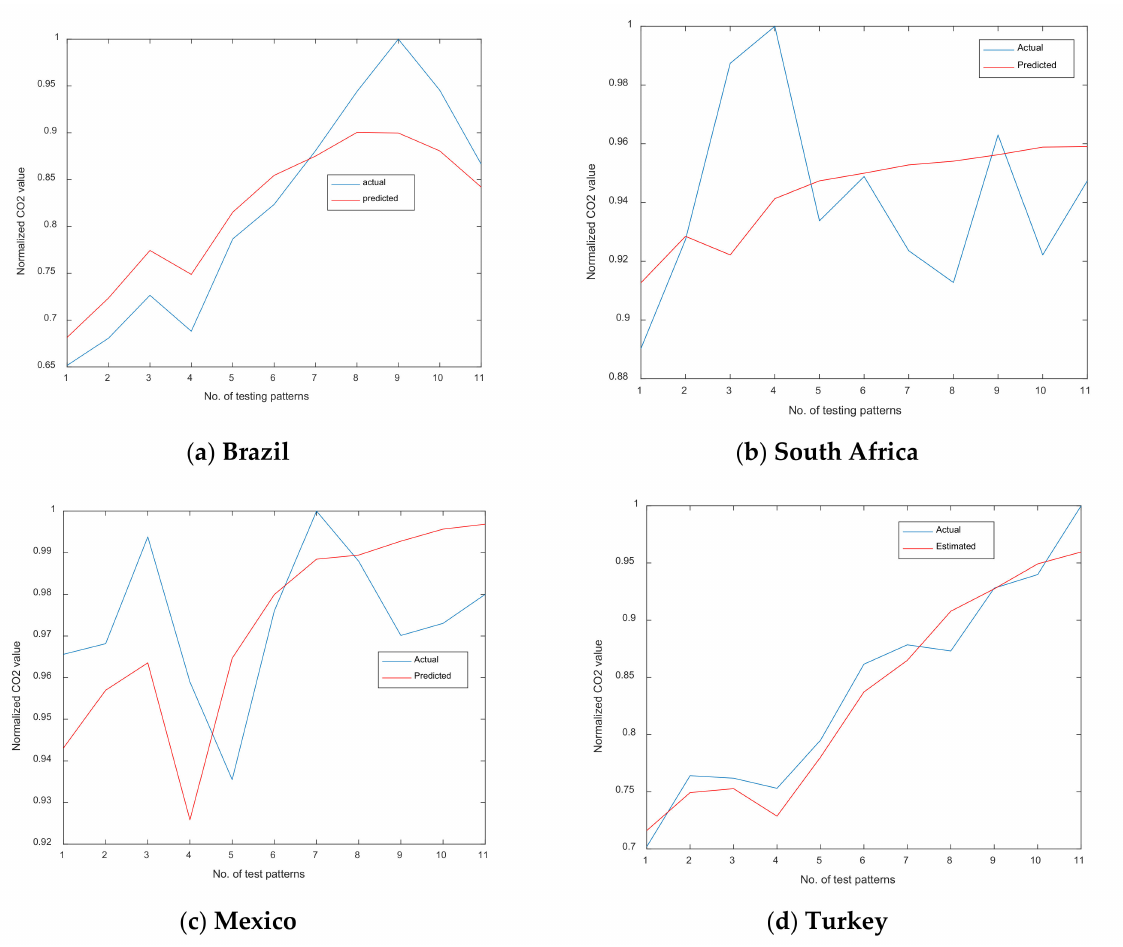
Figure 6. Comparison of the actual and estimated value of CO 2 emissions using the MLANN for Group-1 countries during the testing of the